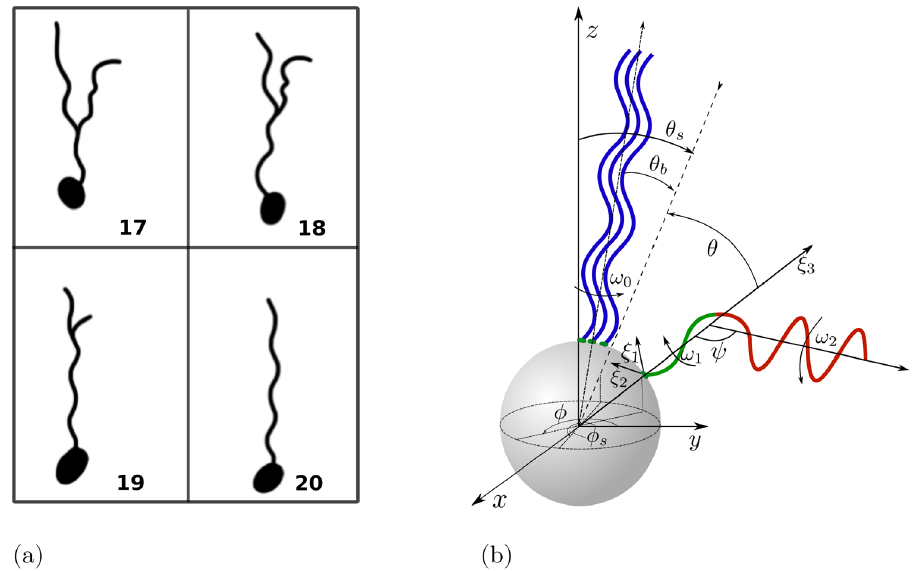
Fig 5. (a) Illustration of the bundling process with one filament changing its polymorphic form based on fluorescent images in Fig. 7 from Ref. [37]; numbers on the drawings correspond to different frames with a time between two consequent frames of 1/60 s. (b) Schematic representation of the bundling process. The green part of the filament is a normal polymorph (near the cell body), while the red part is in semi-coiled form (distal end). The bundle consists of the other three filaments shown in blue.